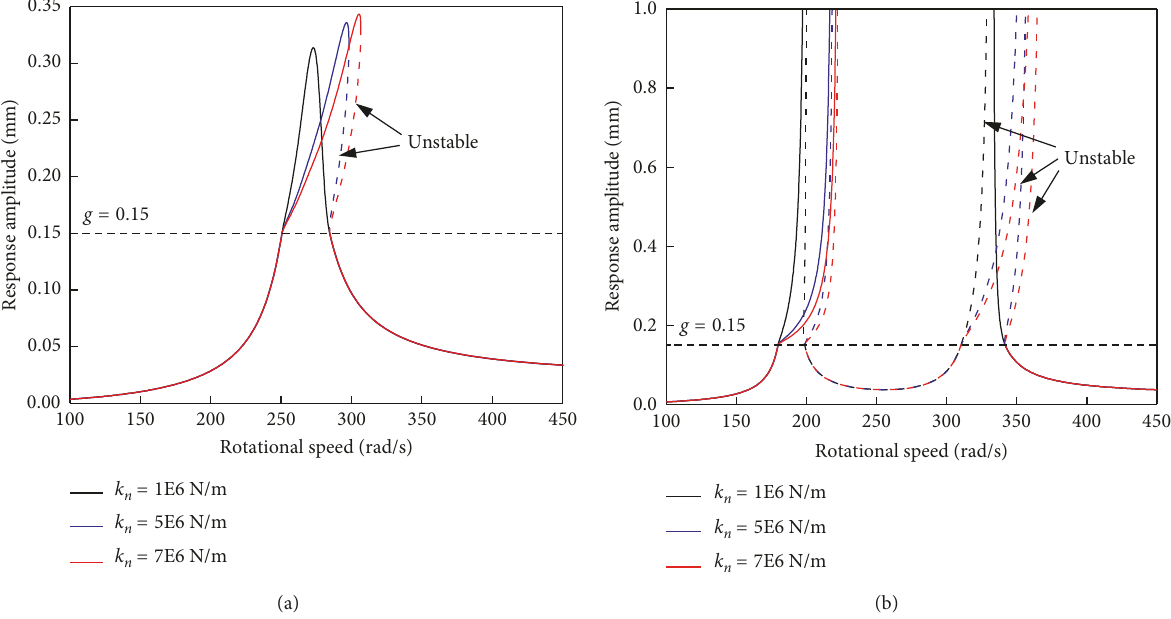
Figure 6: Effects of the stator stiffness on the horizontal amplitudes of disk node: (a) symmetric rotor and (b) asymmetric